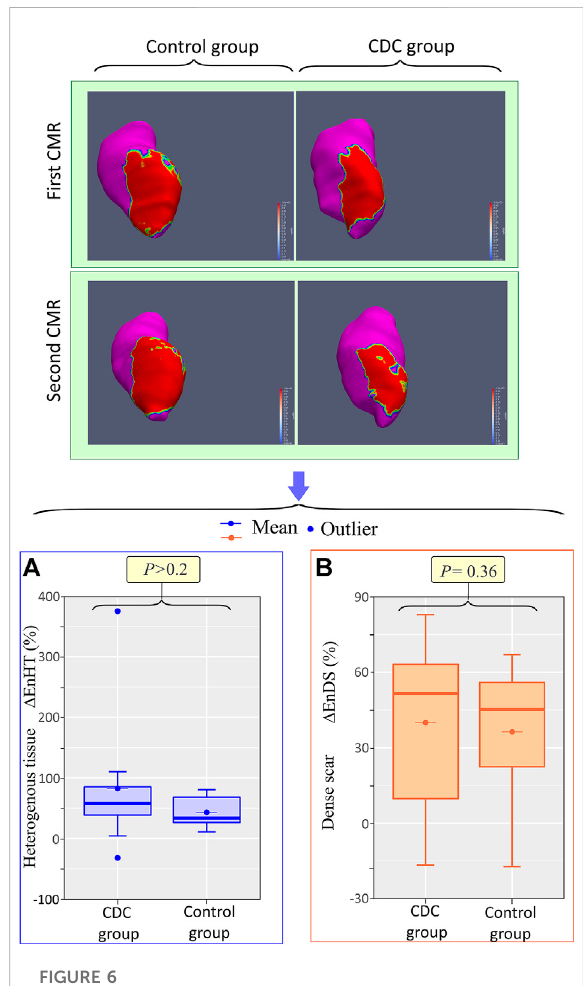
FIGURE 6 Intrapericardial CDCs do not modify endocardial scar composition.Top:endocardialsignalintensitymapsofatreatment andcontrolanimalinthe fi rstandsecondCMR.RedrepresentsDS, magenta HM, and green-yellow HT. Bottom: Boxplots showing the differences in relative percentage changes in endocardial heterogeneous tissue, EnHT (A) and dense scar, EnDS (B) Abbrv: CDC = cardiosphere-derived cells, CMR = cardiac magnetic resonance, Δ EnDS = percentage change in endocardial dense scar, Δ EnHT = percentage change in endocardial heterogeneous